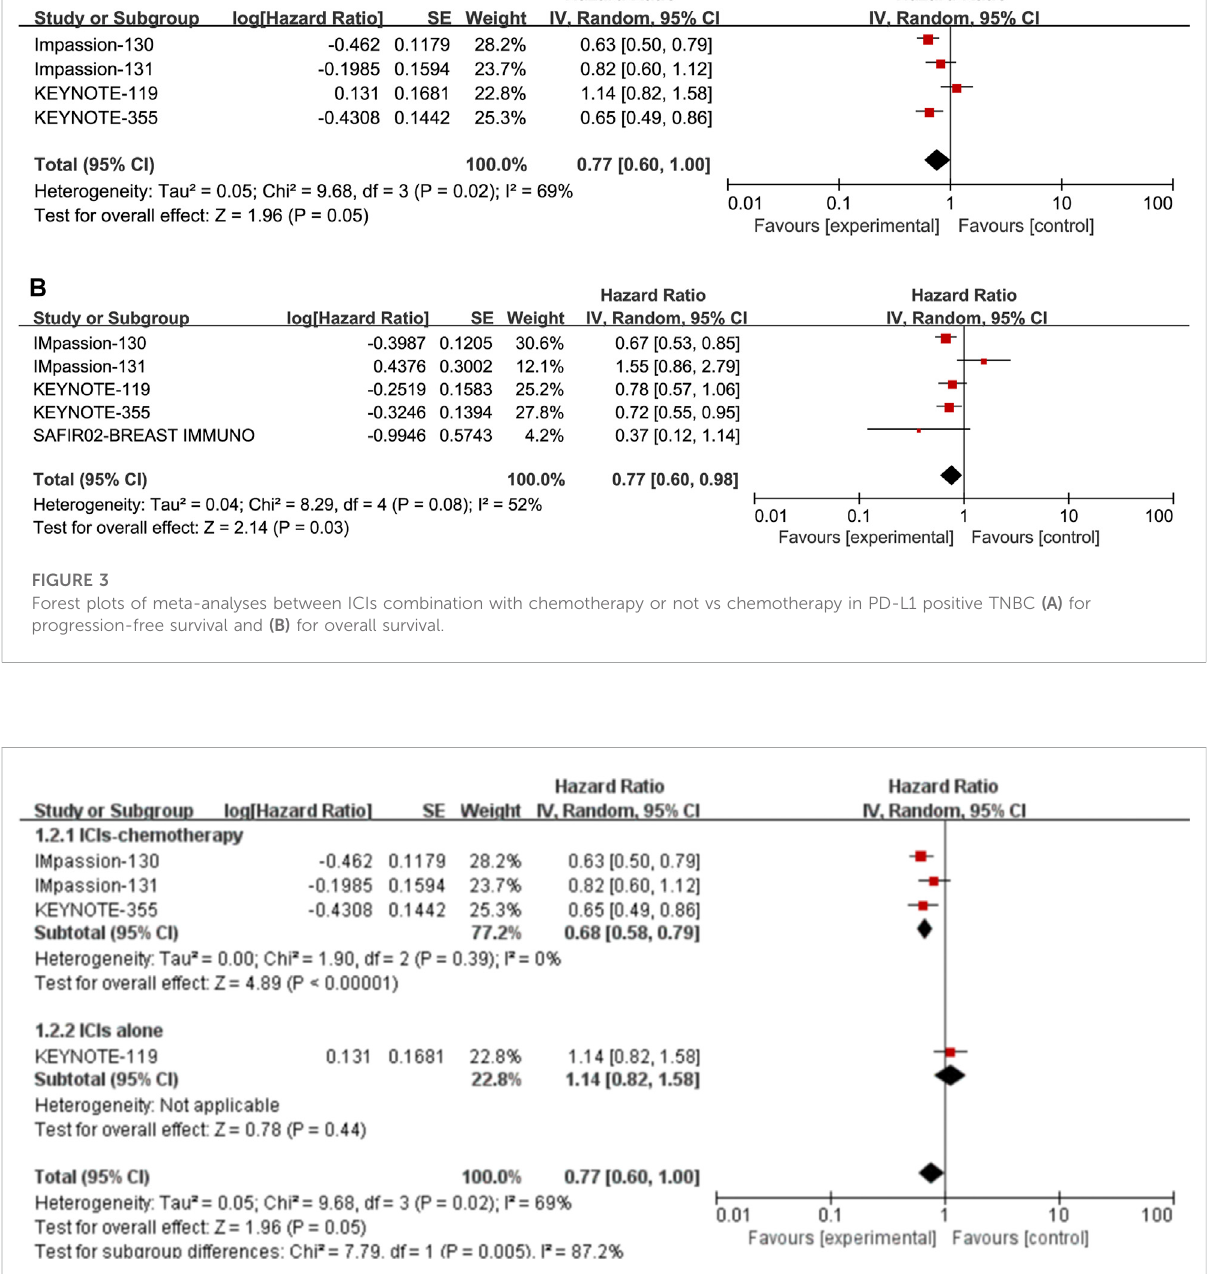
FIGURE 4 Subgroup analysis of the effect of ICIs combined with chemotherapy or not on PFSin PD-L1 positive TNBC